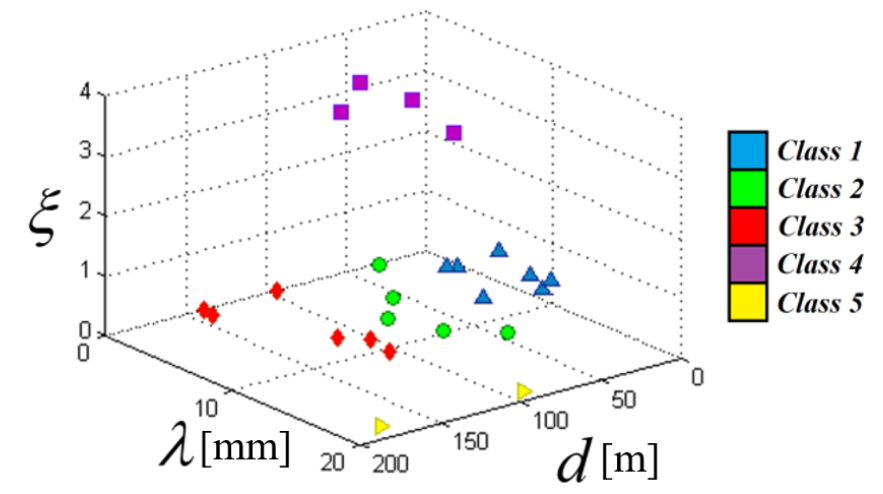
Figure 8. Classification of the measuring points after